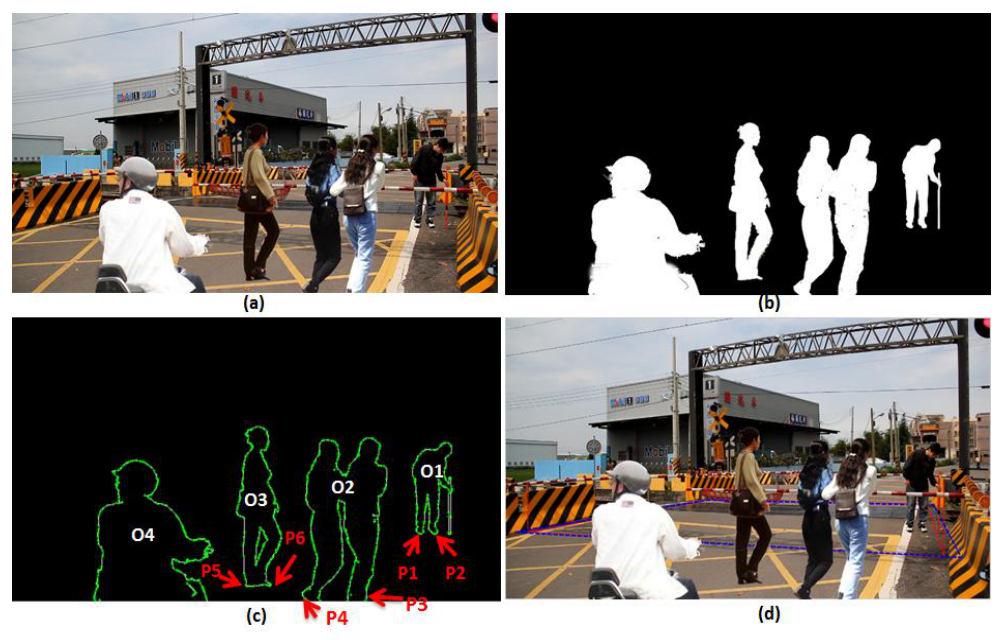
Figure 20. The test image including people taken from Danjan Road; the blue-line area is the detection result, and the red-line area is the real measured result: ( a ) the original image which is the people are in the railway risk area; ( b ) the people extracted as an object; ( c ) the edge image of the object; ( d ) the railway risk area detection result.